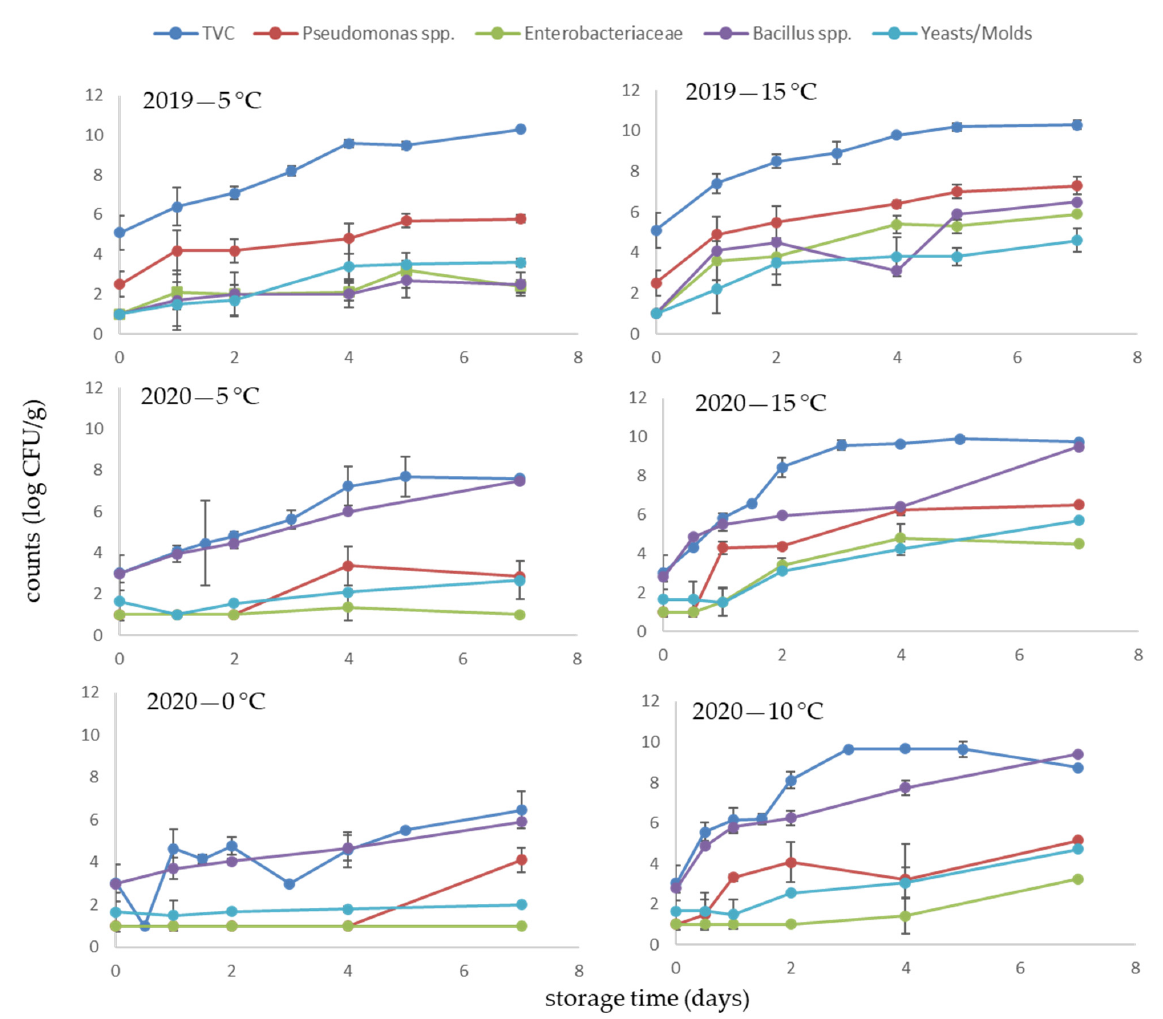
Figure 1. Changes in the microbial counts of A. esculenta stored aerobically at 5 and 15 °C (year 2019) and 0, 5, 10 and 15 °C (year 2020).